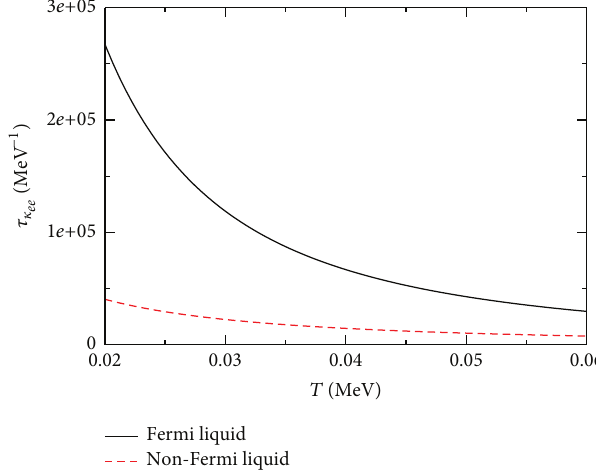
Figure 10: Temperature dependence of the thermal relaxation time and comparison between the Fermi liquid and the non-Fermi-liquid NLO results where 𝛽 ̸= 0 .